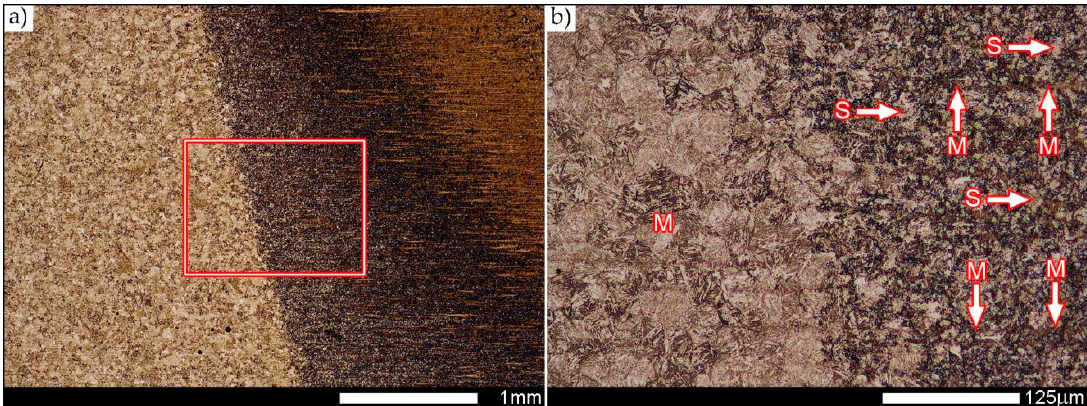
Figure 22. Microstructure of Hardox Extreme welded joint after welding: ( a ) in the area marked ICHAZ in Figure 5; ( b ) an enlarged image marked with frame in Figure 22a. Structure of fine-lath band-like arranged hardening martensite (M) with hardening sorbite (S). Light microscopy, etched with 2% HNO 3 .